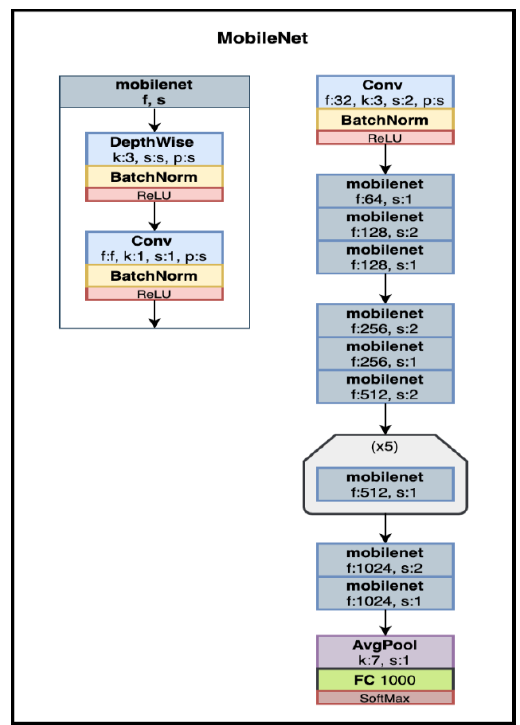
Fig. 4. MobileNet Structure